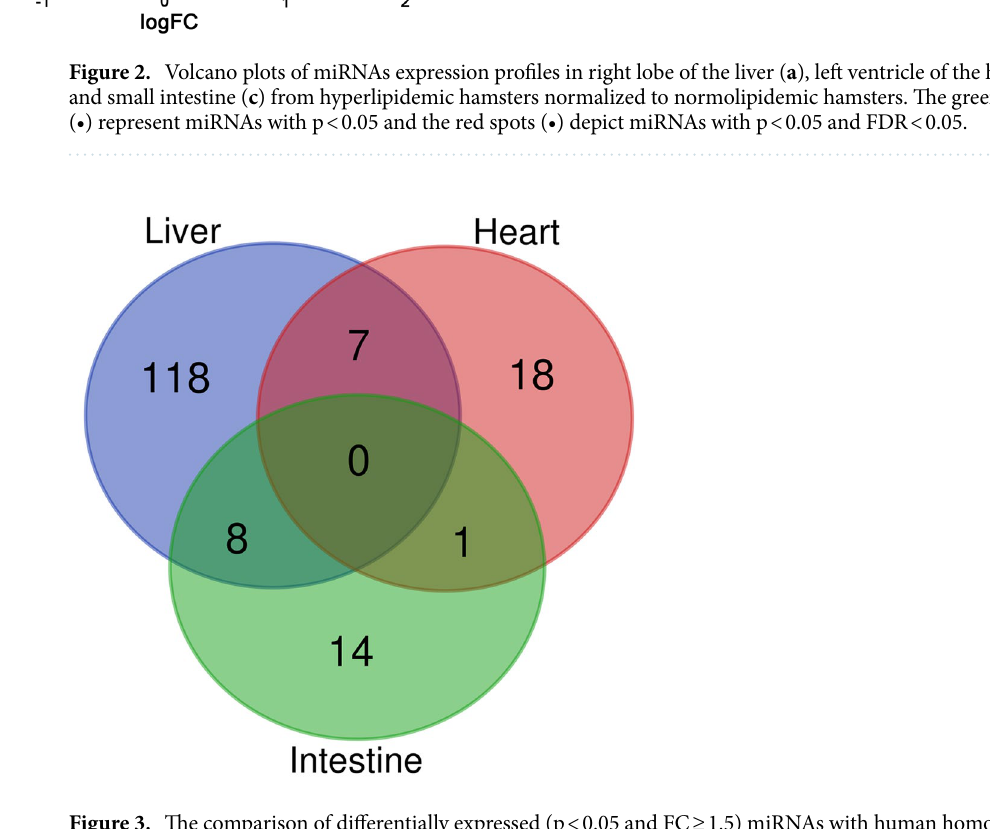
Figure 3. The comparison of differentially expressed (p < 0.05 and FC ≥ 1.5) miRNAs with human homologs in right lobe of the liver, left ventricle of the heart and small intestine. Detailed list of shared miRNAs is shown in Supplementary Table